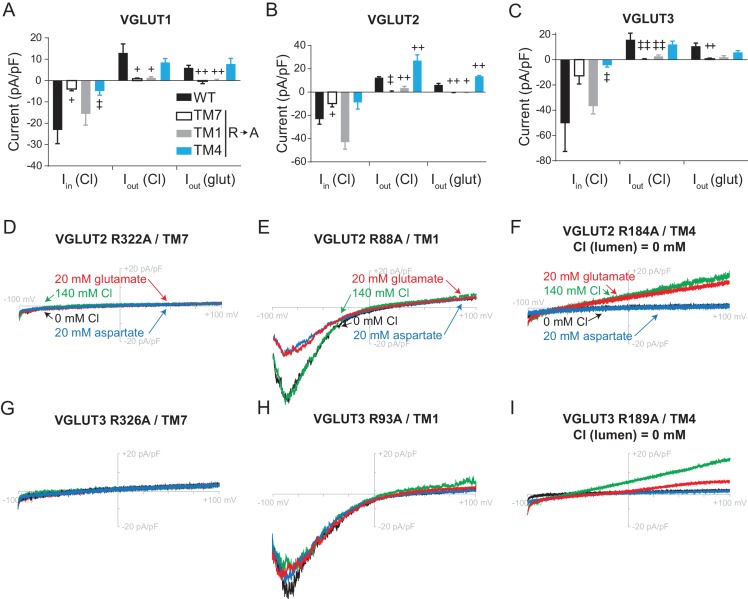
Chloride and glutamate currents in endosomes expressing mutant VGLUTs.Compiled data (A–C) and sample traces (D–I) for alanine substitutions at conserved arginine residues in TM7, 1 and 4 of VGLUT1 (A), VGLUT2 (B,D–F) and VGLUT3 (C,G–I). All endosomes were recorded with 140 mM NMDG Cl at pH 5.0 in the pipette (n = 3–5) except for those expressing the arginine mutant in TM4, which were recorded with 140 mM NMDG gluconate (0 mM Cl-) in the pipette (n = 4–7). The baselines for outward Cl- and glutamate currents were defined as in Figure 1—figure supplement 1 and Figure 2—figure supplement 2. Bar graphs indicate mean ± SEM. +p<0.05, ++p<0.01 by unpaired t-test and ‡p<0.05, ‡‡p<0.01 by Mann-Whitney test.